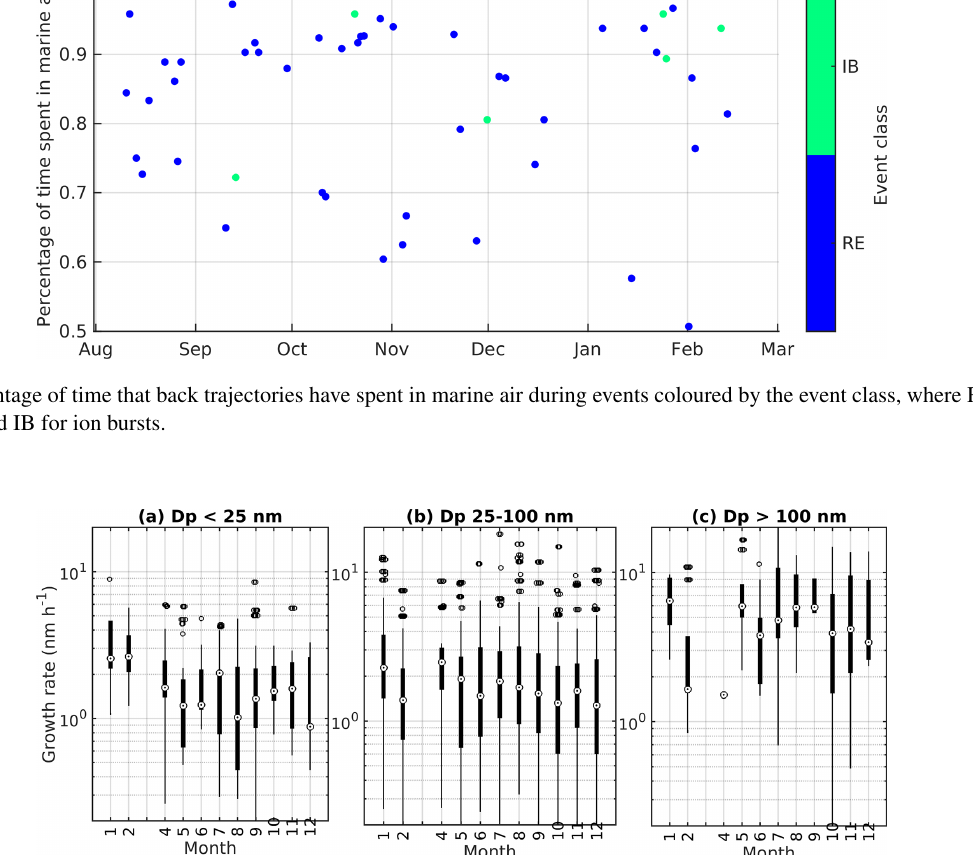
Figure B4. Seasonal cycles of growth rates in different